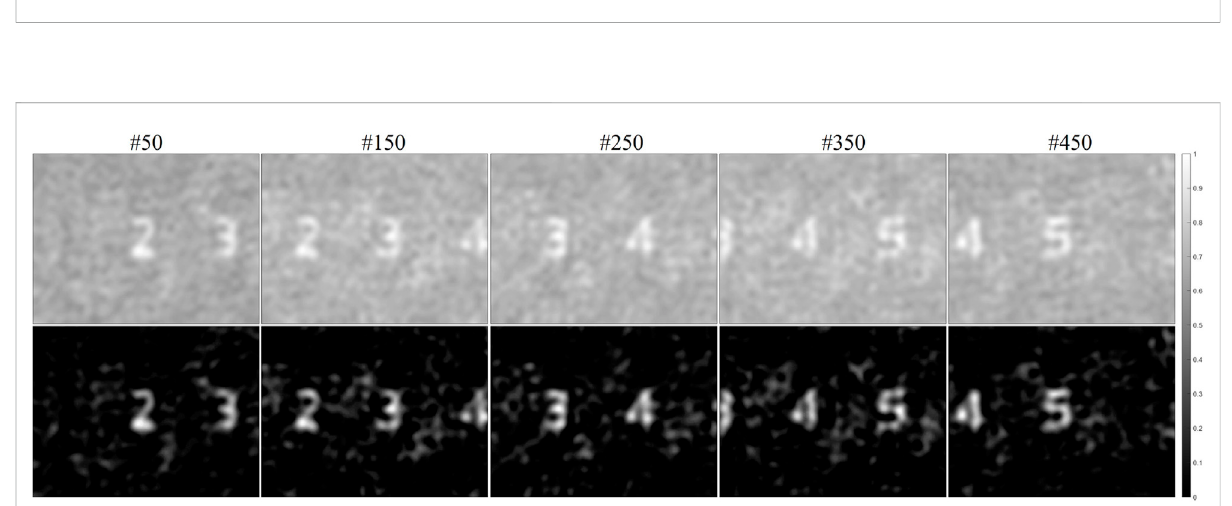
FIGURE 3 Signal of the ampli fi ed bucket detection. Each green pulse indicates when the controller triggered an operation of refreshing EOPMs ’ phases. The separation of two adjacent pulses is 200 ns. The blue curve is the output from the ampli fi er that linearly ampli fi ed the signal from the bucket detector, whose value jumped once the controller generated a new random speckle pattern.